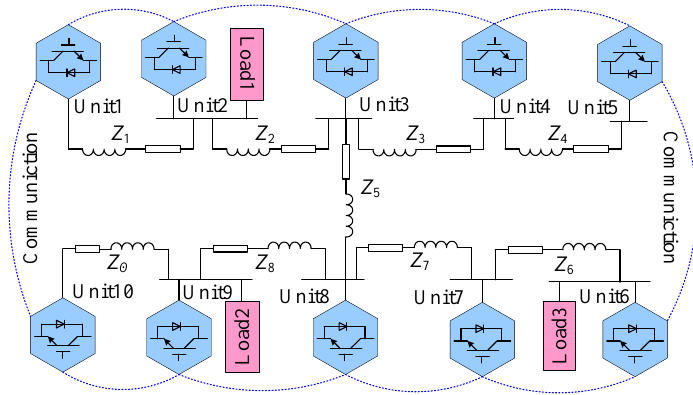
Figure 6. The large system with ten inverters.